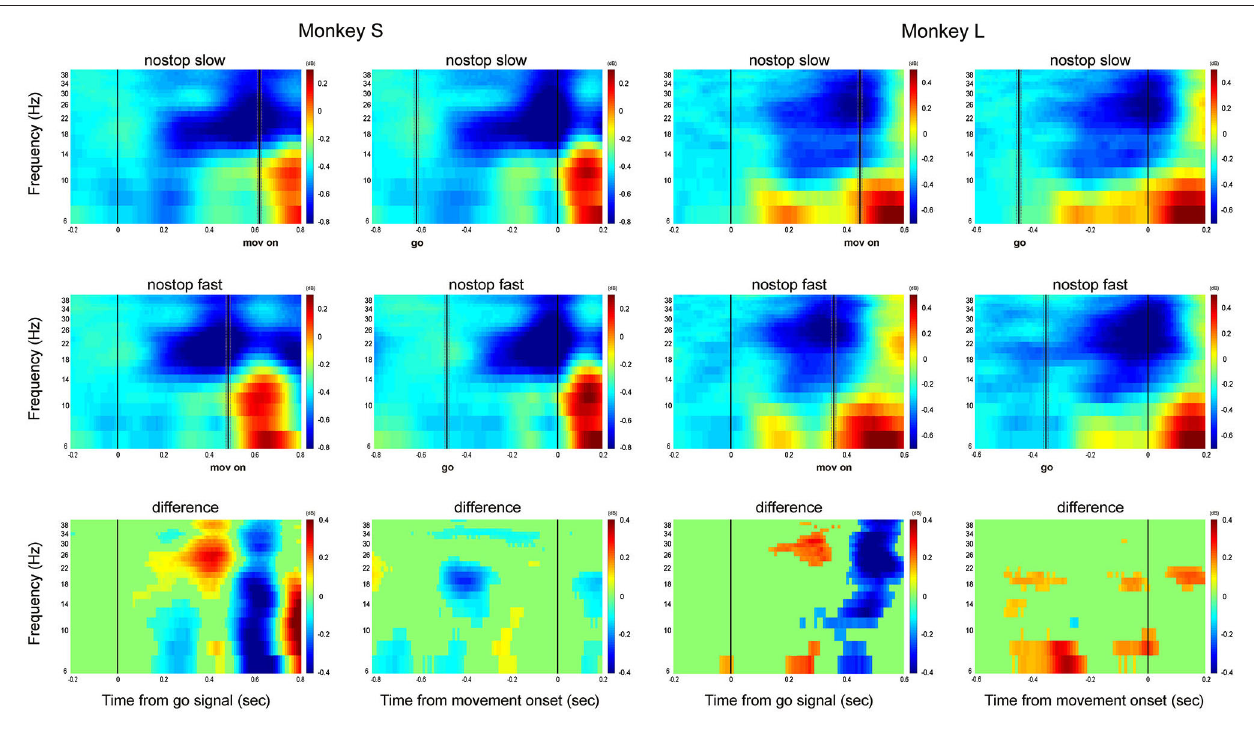
onset (mov on). Top row: grand average of slowest responses. Middle row: grand average of fastest responses. Bottom row: difference between slowest and fastest responses. Dotted lines represent mean ± SD of RT in the left column and of the Go signal in the right